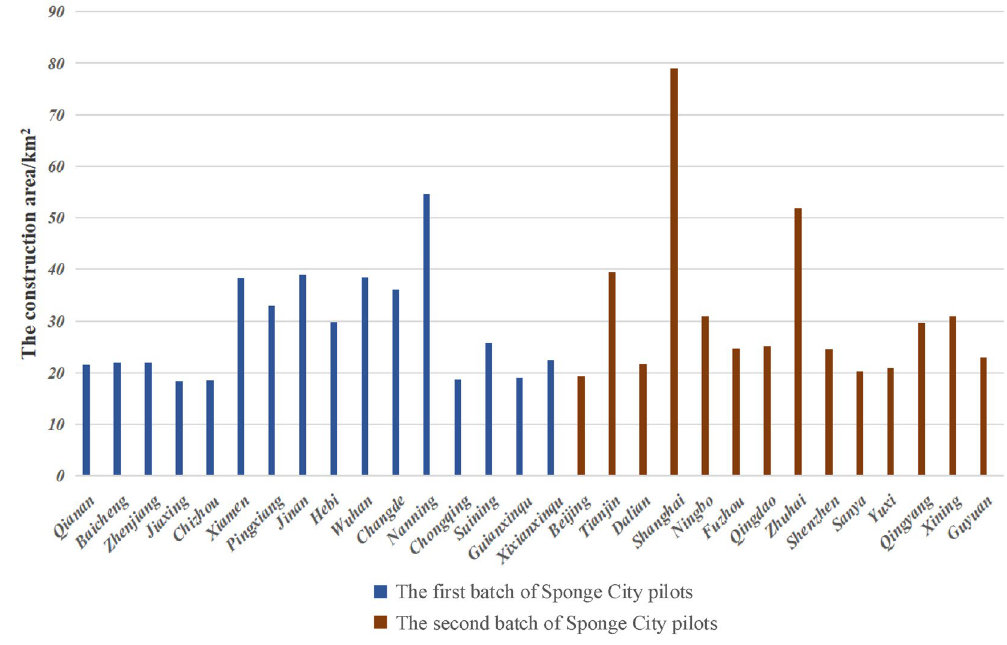
Figure 3. The construction area of Sponge City projects in